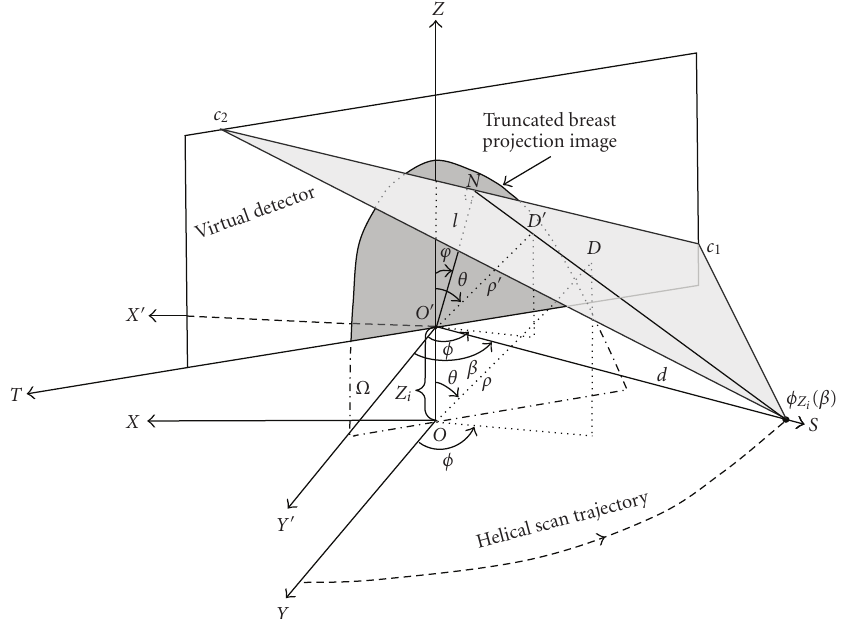
Figure 5: The Geometrical illustration of the same Radon value defined in object coordinates and reconstruction coordinates associated with the partial helical